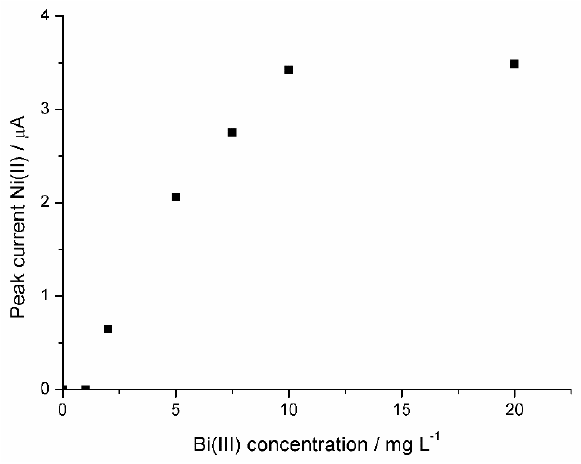
Figure 2. Effect of Bi(III) concentration on the Ni(II) peak current. Concentration of Ni(II): 10 µg∙L −1 ; accumulation conditions: 60 s at −0.8 V. Other experimental conditions as in Figure 1.